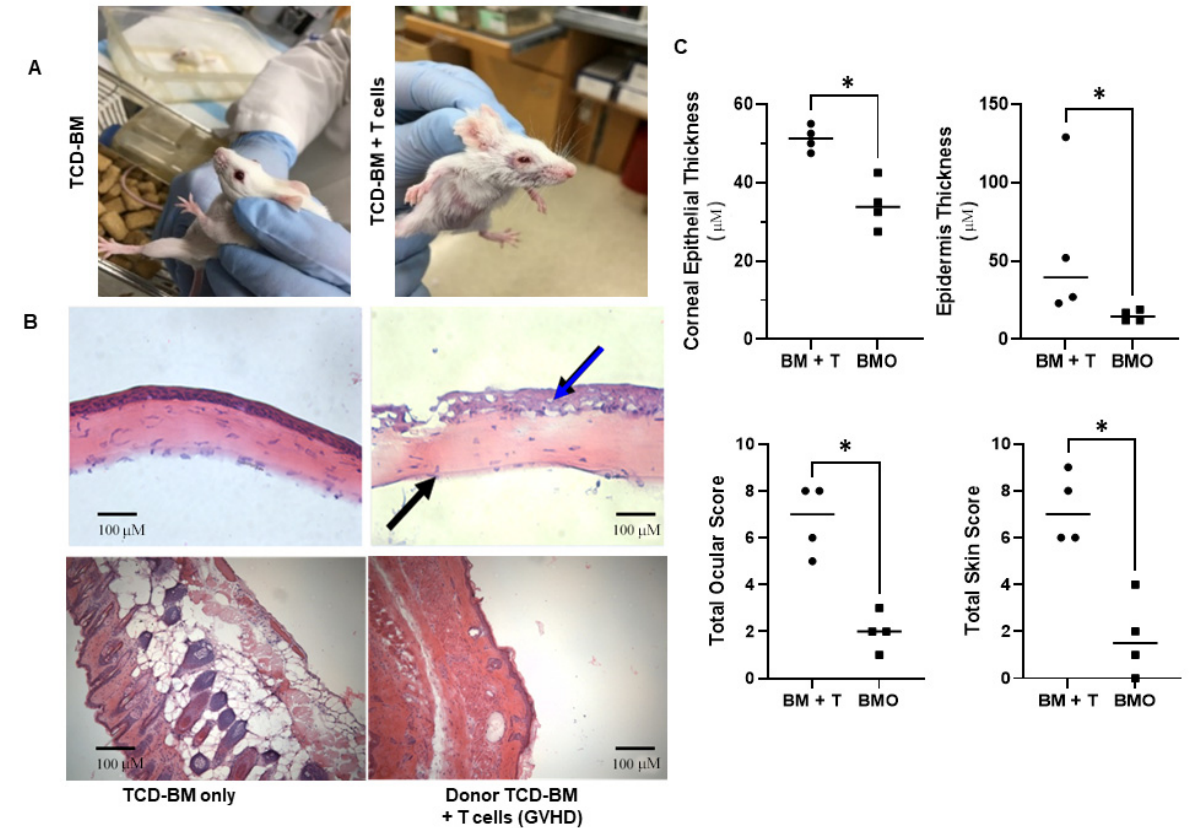
Figure 3. Development of ocular and skin GVHD following HSCT in an MHC-matched donor/recipient strain combination. Transplants were performed using donor B10.D2 (H2d) bone marrow +/ − spleen cells containing T cells into BALB/c (H2d) recipients. ( A ) Clinical examination of animals